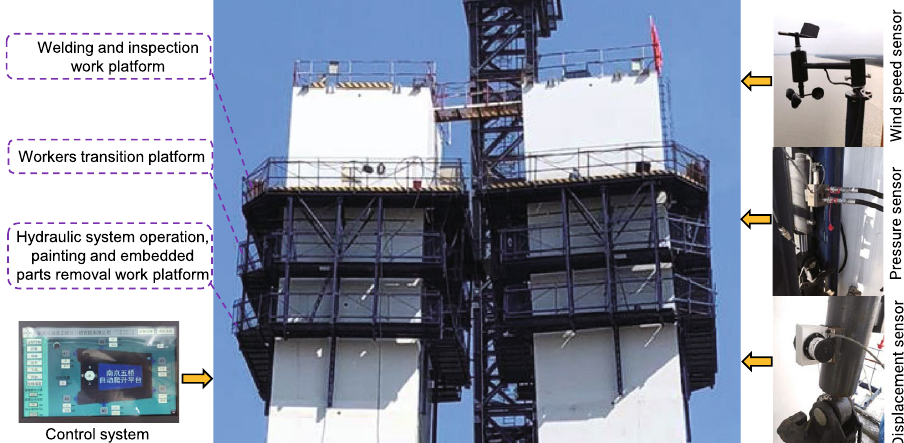
Figure 17. Hydraulic automatic climbing operating